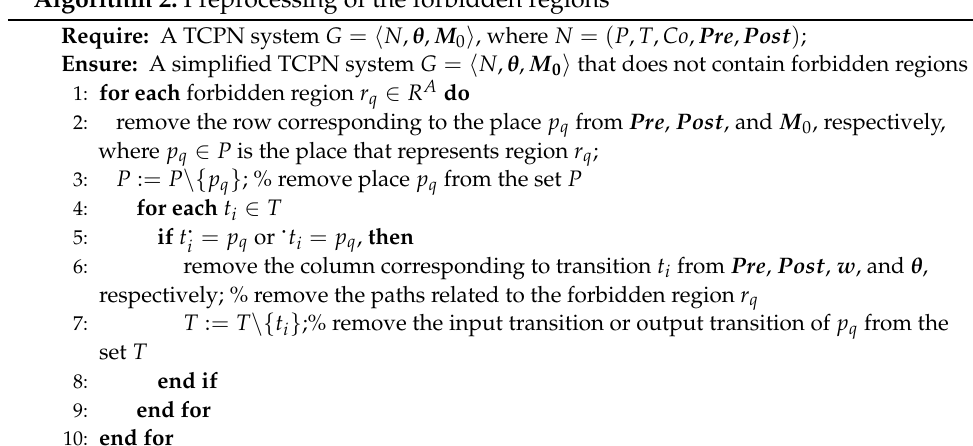
Algorithm 2: Preprocessing of the forbidden